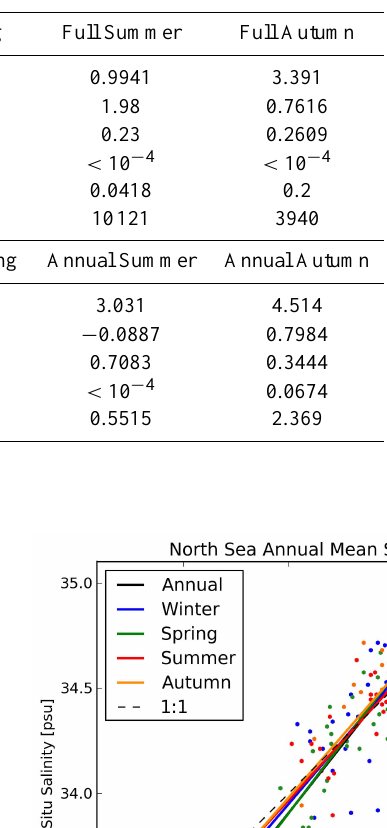
Table 5. Linear regression output parameters for chlorophyll.